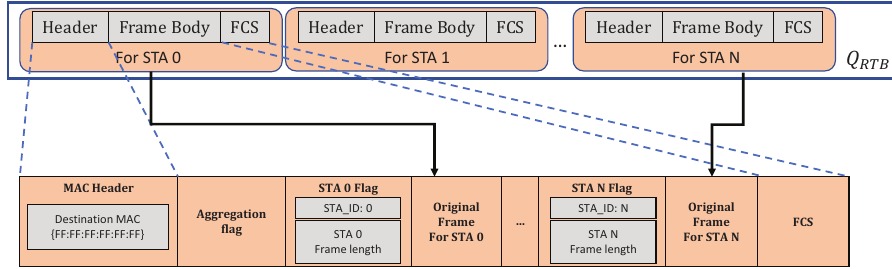
Figure 3. Typical FGA frame